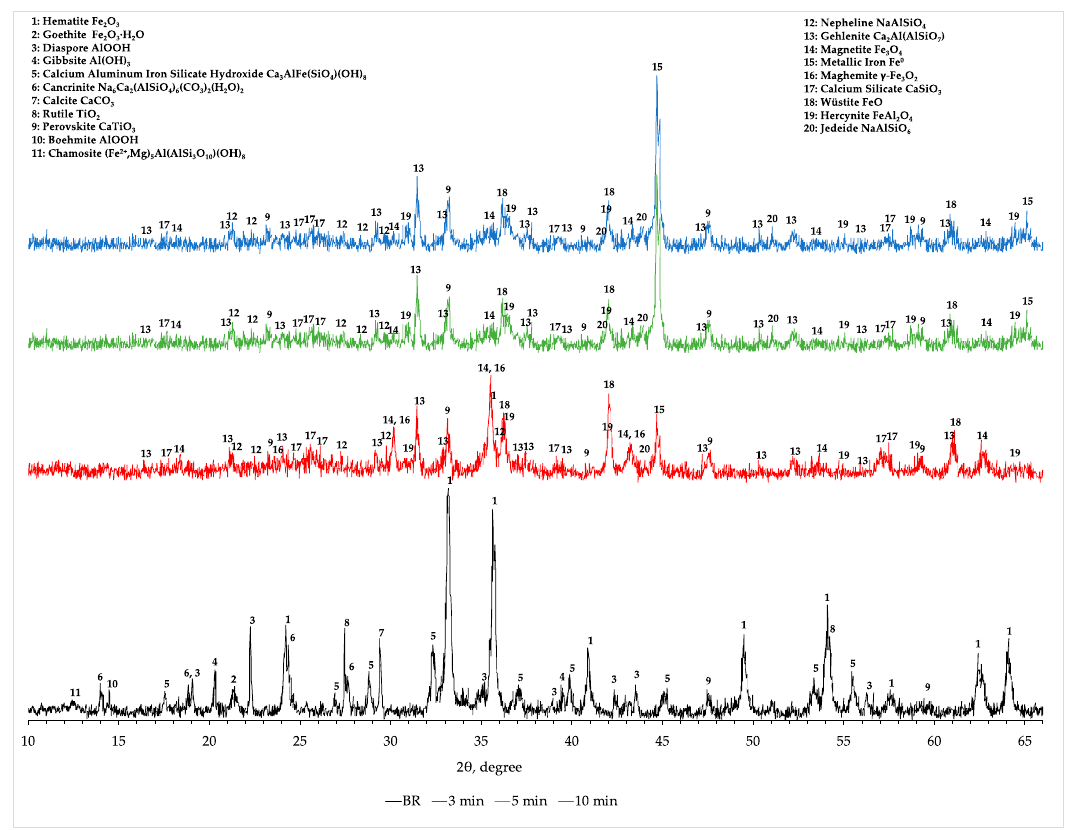
Figure 6. XRD of sinters (C/BR 0.180, 0.6 kW, and 1 L/min N 2 flow) by changing the irradiation time at 180 s, 300 s, and 600 s compared with XRD of bauxite residue.